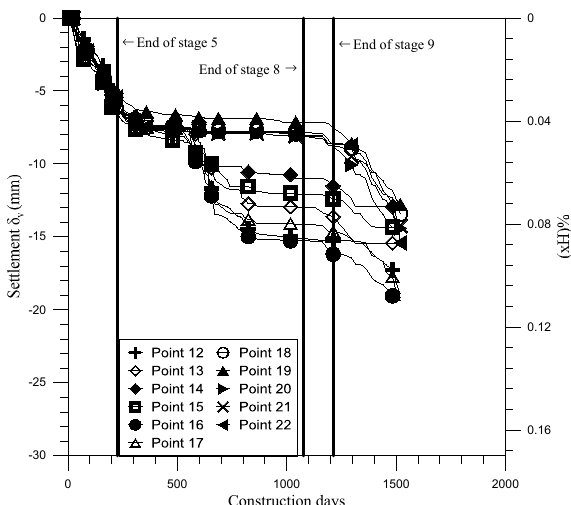
Figure 8. Settlement of points 12–22 of wall.